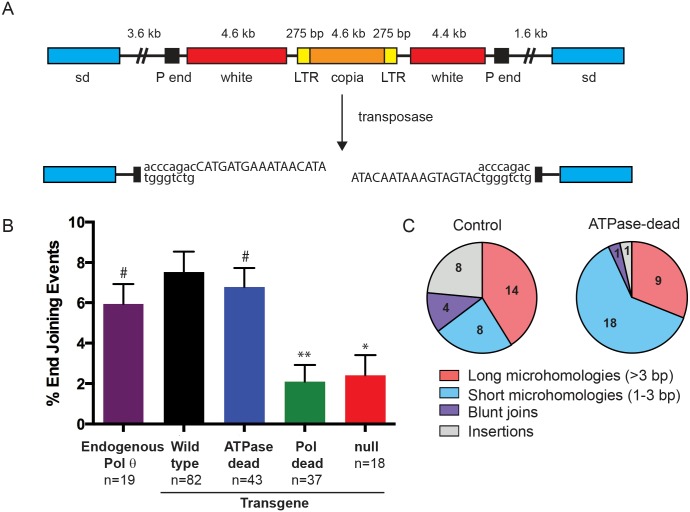
Pol θ ATPase activity does not affect end joining frequency but promotes the formation of complex insertions.A. Schematic of the P{wa} construct (top). After expression of transposase, the P-element is excised leaving 17 nt overhangs (bottom). B. Frequency of end joining repair in domain-specific transgenic alleles and controls. All transgenes are in a mus308Δ, spn-A (rad51) background. The number of independent vials (n) represented by each bar and the standard error of the mean is shown. C. Summary of junction types recovered in control and ATPase-dead transgenic alleles. *p<0.05, **p<0.01, # p = n.s. compared to wild-type control, two-way ANOVA, Tukey’s post hoc test.